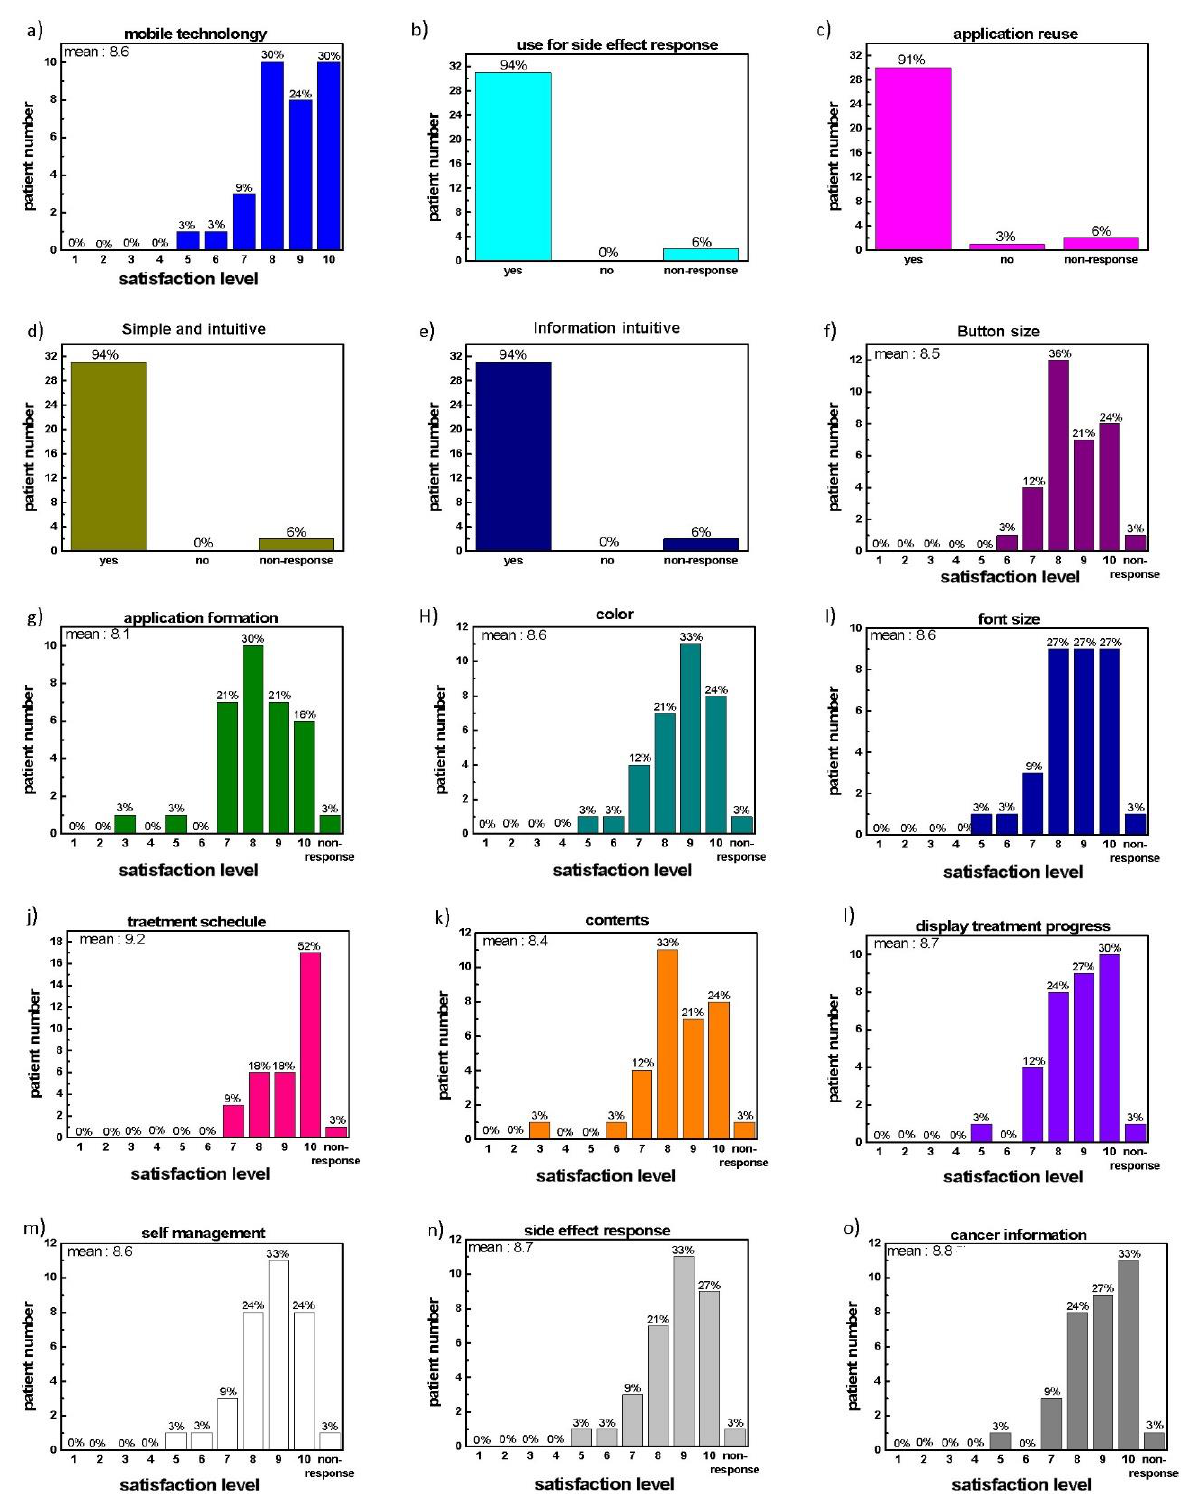
Figure 8. The items evaluated by questionnaire: ( a ) positive perception of mobile technology, ( b ) the possibility to report side effects, ( c ) the possibility of application re-use, ( d ) simple and intuitive application, ( e ) information intuitive, ( f ) button size, ( g ) formation of application, ( h ) color of application, ( i ) font size, ( j ) satisfaction with treatment schedule function, ( k ) satisfaction with contents, ( l ) satisfaction with treatment progression display, ( m ) satisfaction with self-management, ( n ) satisfaction with side effect reporting, ( o ) satisfaction with cancer information.